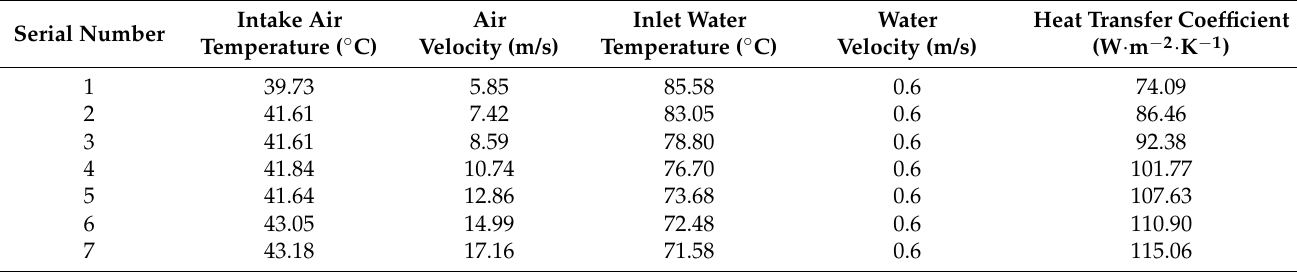
Table 2. Radiator test